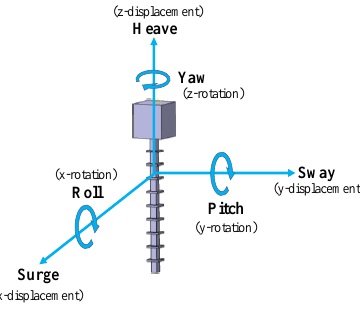
Figure 6. The six degrees of freedom of the displacement modules at the free surface of the wave .